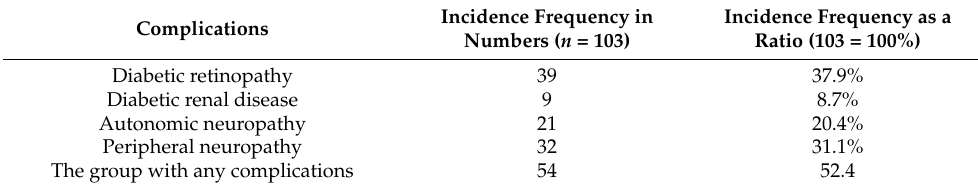
Table 2. Incidence of complication in the study group.